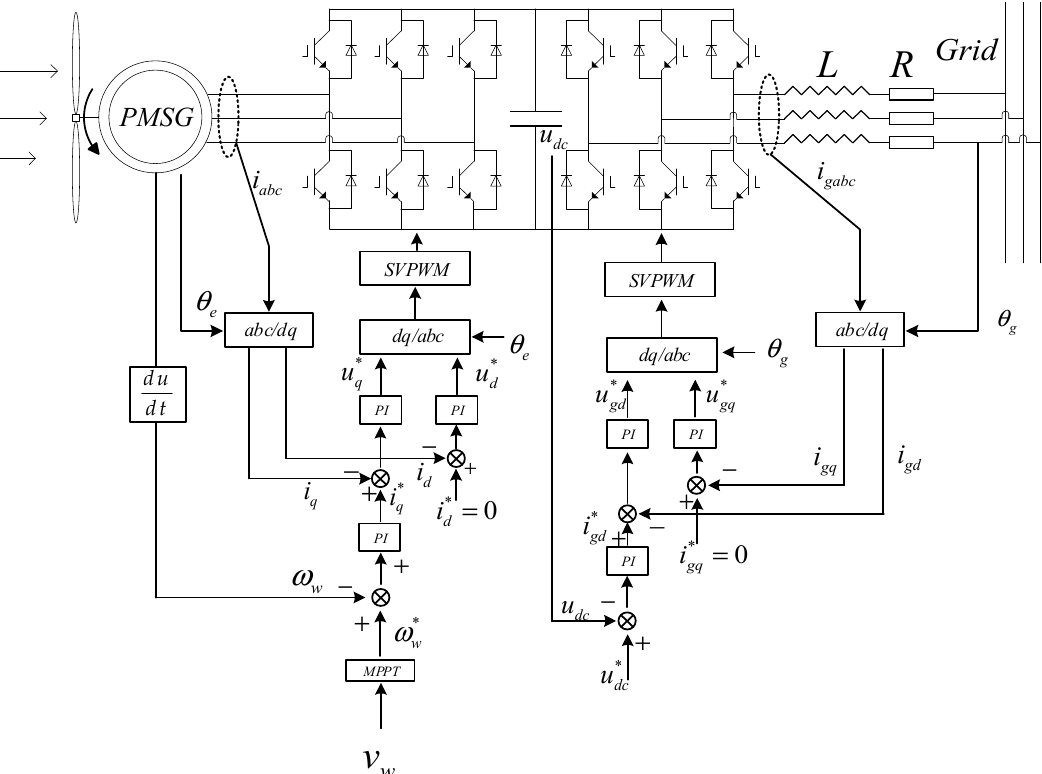
Figure 2. The topology of the permanent magnet synchronous wind turbine (PMSWT) system and dual-loop control strategy.